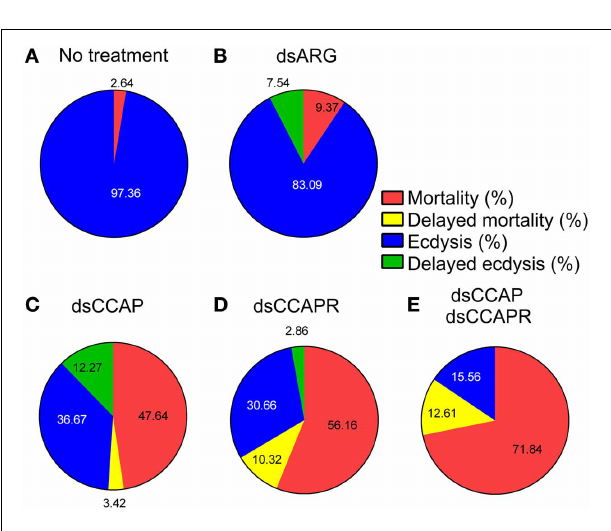
FIGURE 8 | Summary of the effects of knockdown of CCAP and CCAPR on R. prolixus ecdysis. Four different categories were investigated; % mortality, % delayed mortality, % ecdysis and % delayed ecdysis. The percentage of mortality and delayed mortality was calculated up to Day 14 post-fed (PF), and after Day 15PF, respectively. The percentage of ecdysis or delayed ecdysis was calculated on bugs up to Day 14PF, and after Day15PF, respectively. (A) No treatment. (B) Control injected with dsARG. (C) Injected with dsCCAP. (D) Injected with dsCCAPR. (E) Injected with both dsCCAP and dsCCAPR. Overall, high mortality rate and delayed ecdysis was observed in experimental groups that were treated with dsCCAP, dsCCAPR or